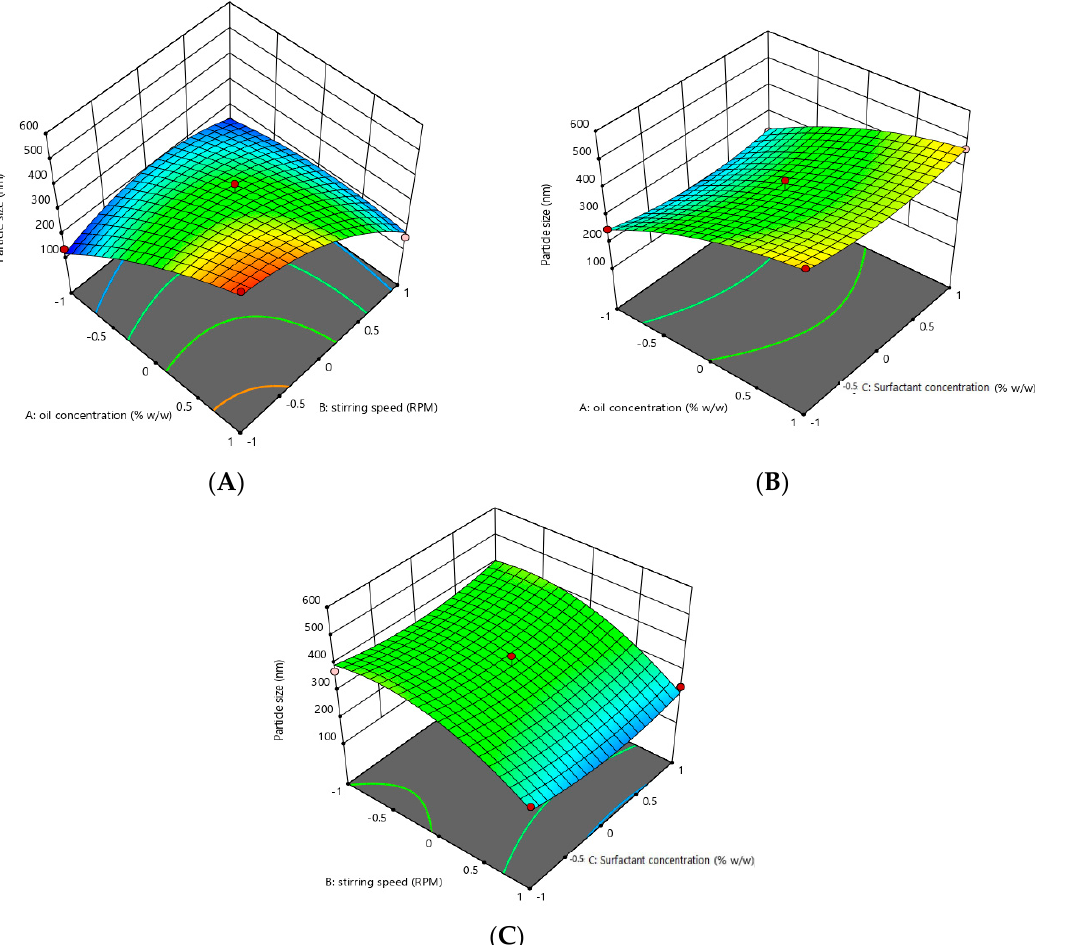
Figure 3. Three-dimensional plot showing effect of independent factors X1 (oil concentration), X2 (stirring speed) and X3 (surfactants concentration) on responses Y1 (particle size) and Y2. ( A ) effect of oil concentration and stirring speed on particle size. ( B ) effect oil concentration and surfactant concentration on particle size. ( C ) effect stirring speed and surfactant concentration on particle size